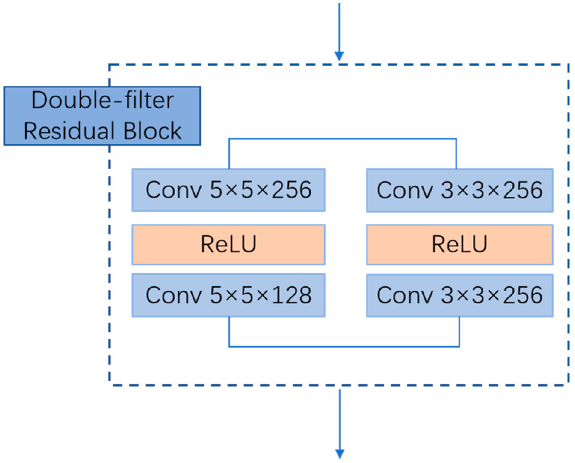
Figure 3. The structure of the double-filter residual block.